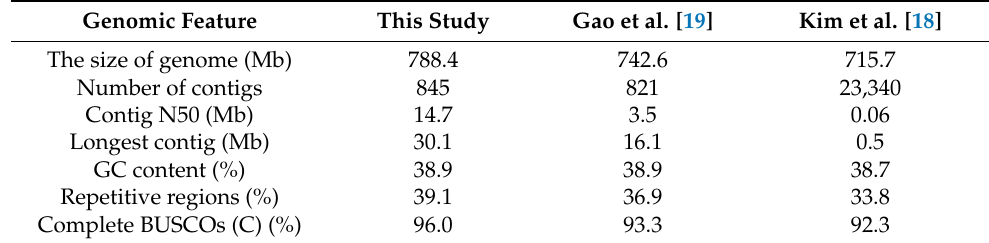
Table 6. Comparison of quality metrics of this study and the previous striped catfish genome